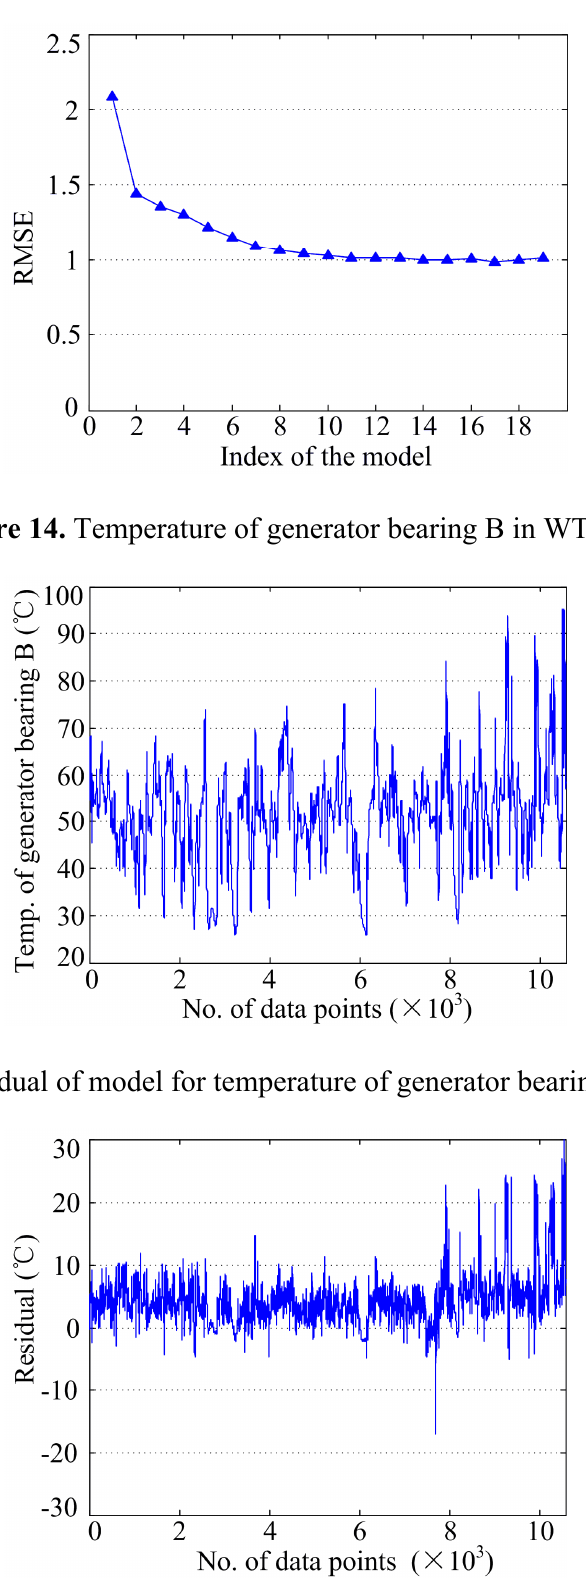
Figure 13. The change of RMSE versus the increase of input parameters of the model for temperature of the output shaft of gearbox.